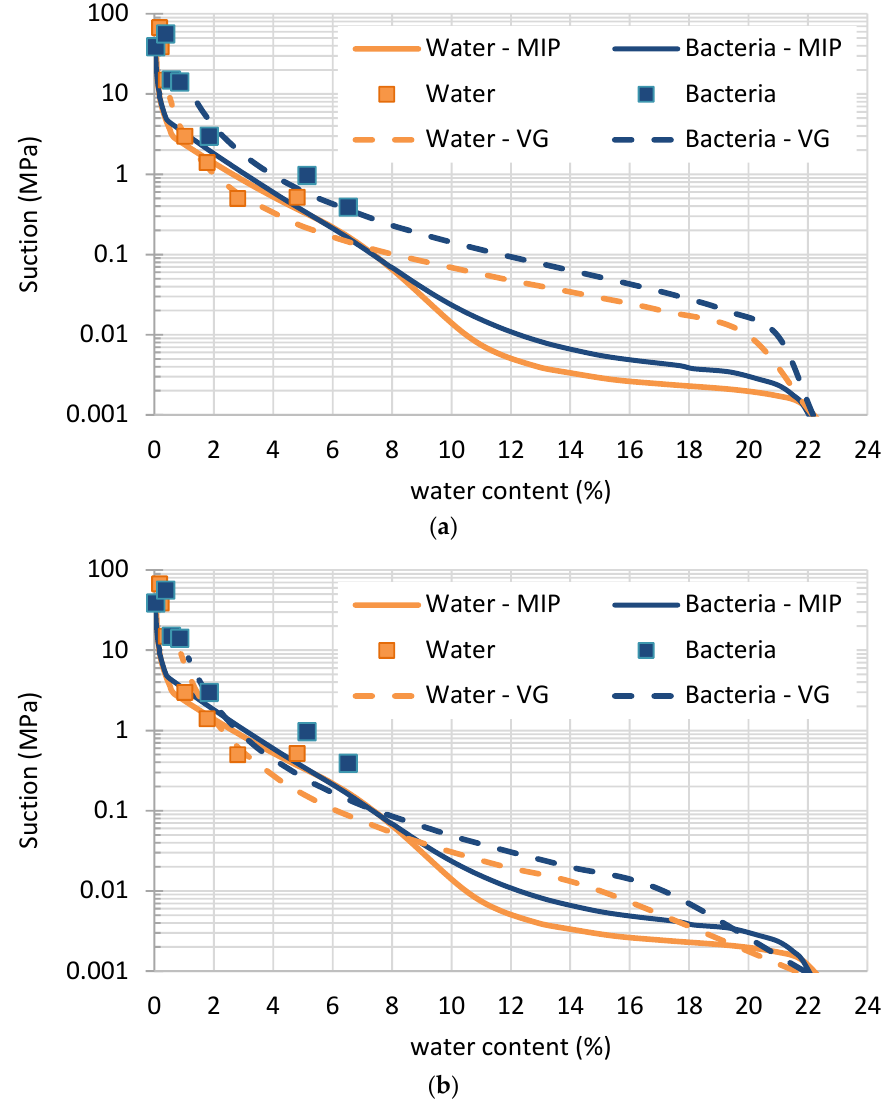
Figure 7. Adjustment water-retention data, using the equation proposed by Van Genuchten [17] (Equation (12)) to fit ( a ) the experimental points and ( b ) the curve computed by using pore size distribution. (Bacteria — biocemented soil; water — untreated soil in natural state).